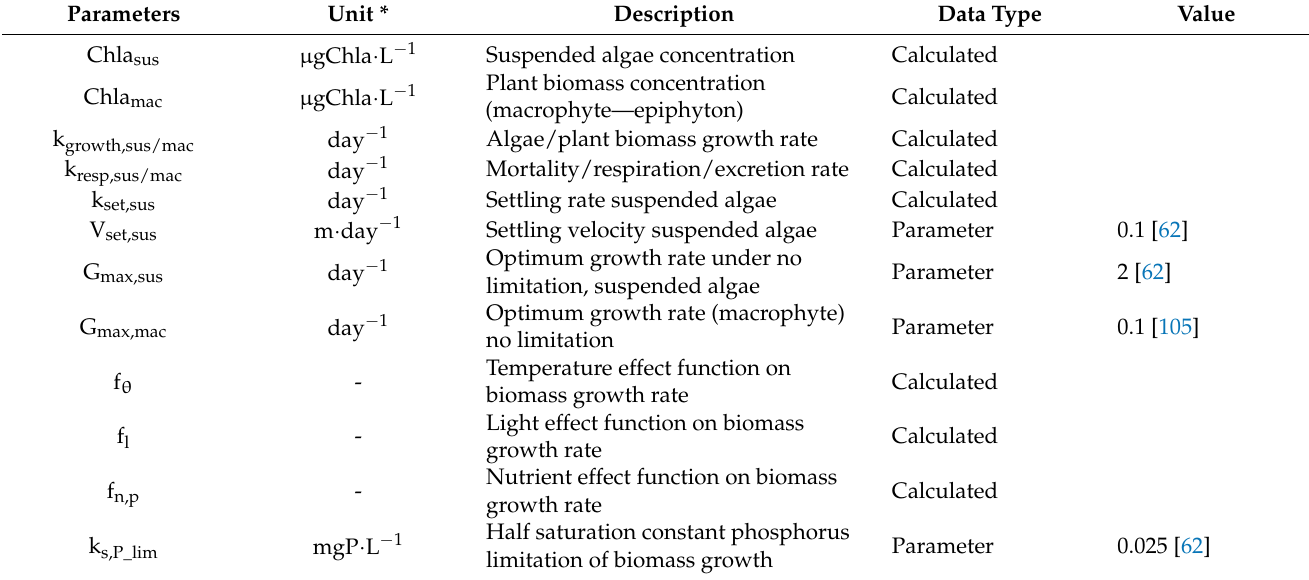
Table A6. Freshwater plant and algae